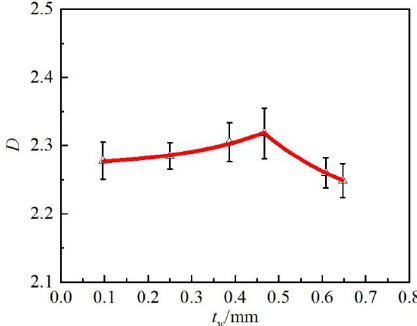
Figure 8. Relationship between the fractal dimensions and corrosion